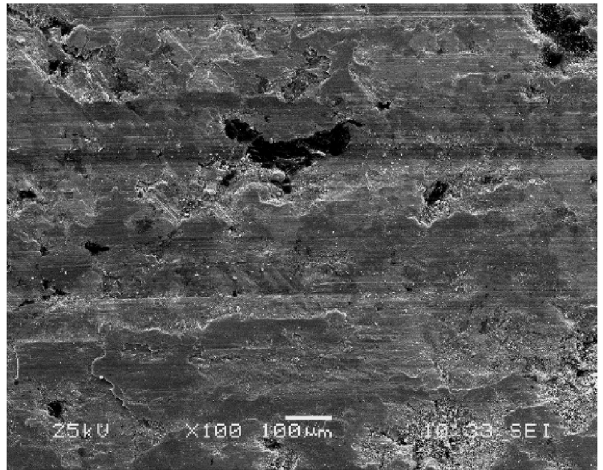
Fig. 8 SEM micrograph showing the worn surface with a number of furrows